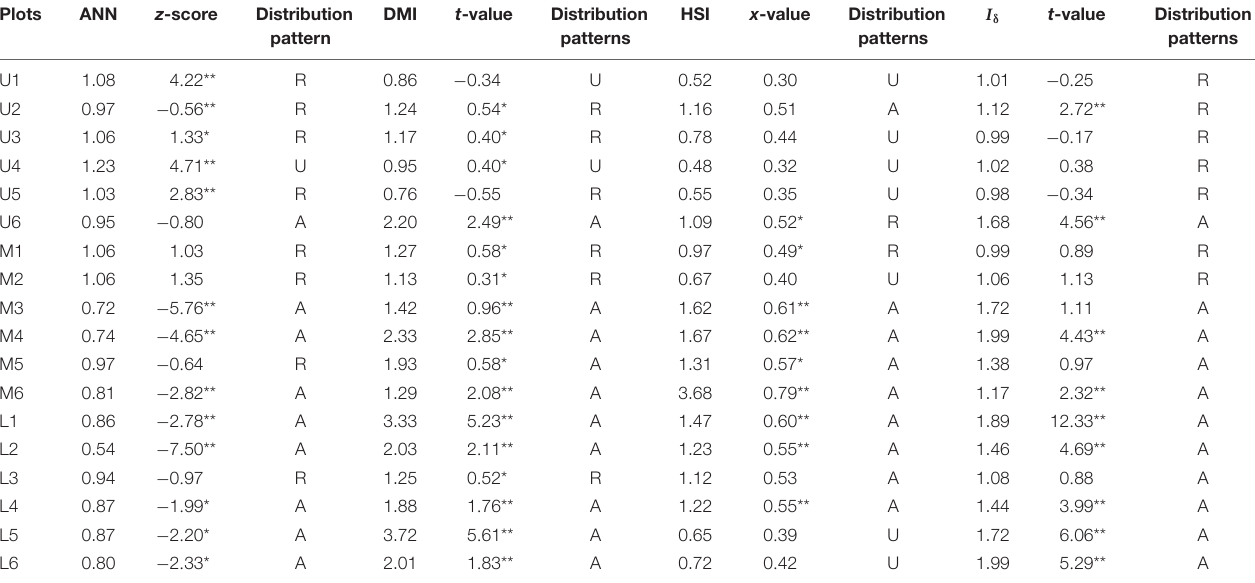
TABLE 3 | Spatial distribution pattern index of ANN, DMI, HIS, and I δ analysis results of P. euphratica in the three river transects. Plots ANN z -score Distribution